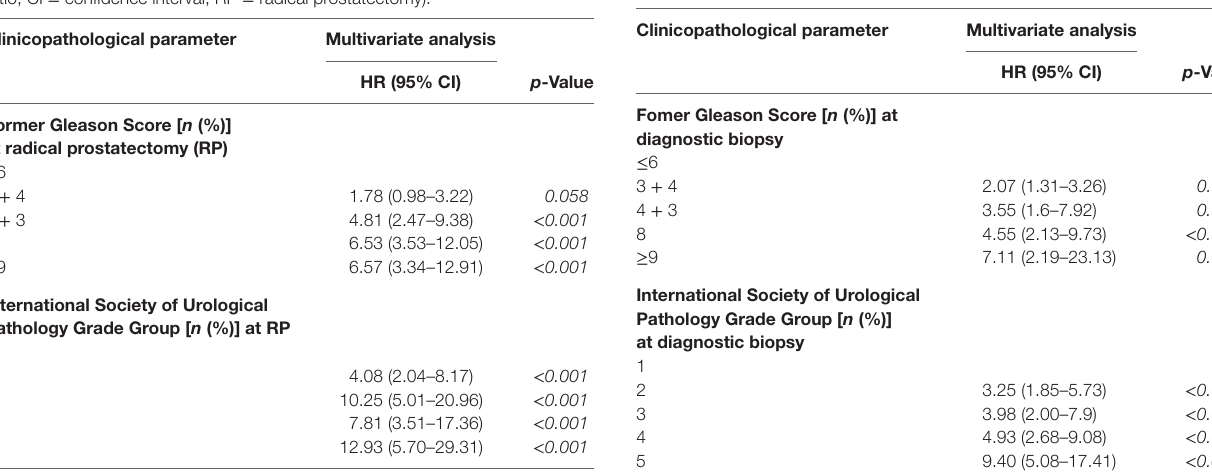
Table 4 | Multivariate Cox analysis for Biochemical recurrence-free survival (BFS) according to different grading systems on biopsies (HR = hazard ratio, CI = confidence interval, RP = radical